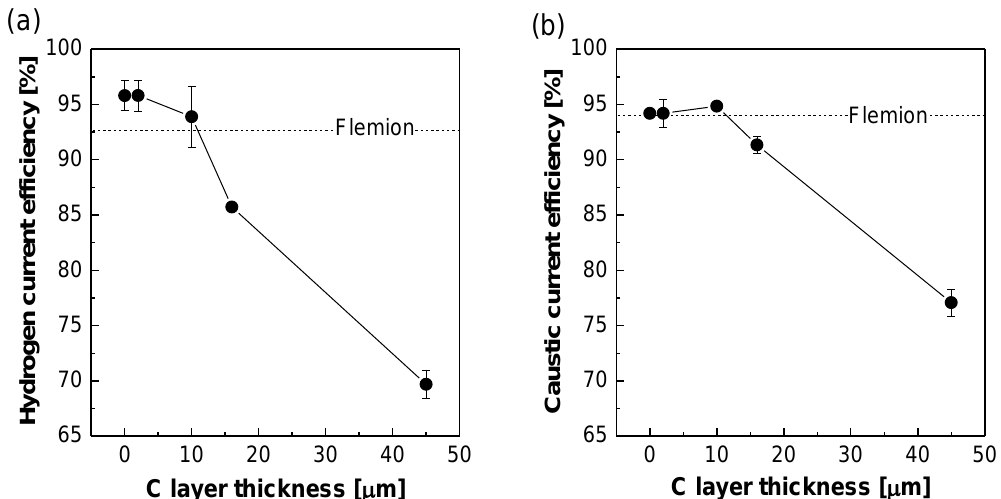
Figure 10. ( a ) Hydrogen and ( b ) caustic current efficiency of NR212/AA-DVB membranes as a function of C layer thickness at the constant current density of 0.6 A·cm −2 . Here, the saline water electrolysis (SWE) operation temperature is 90 °C.